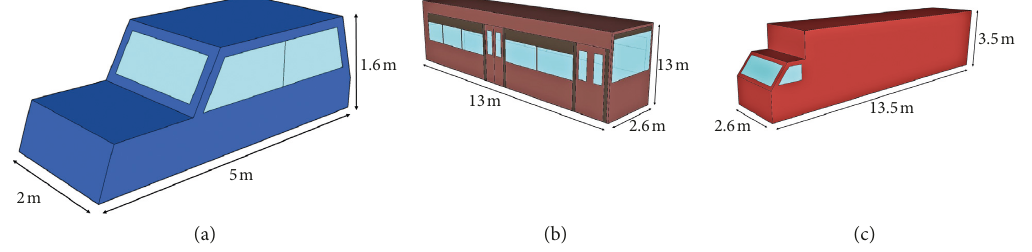
Figure 4: 3D models of different vehicle types. (a) Passenger car model. (b) Bus model. (c) Delivery van